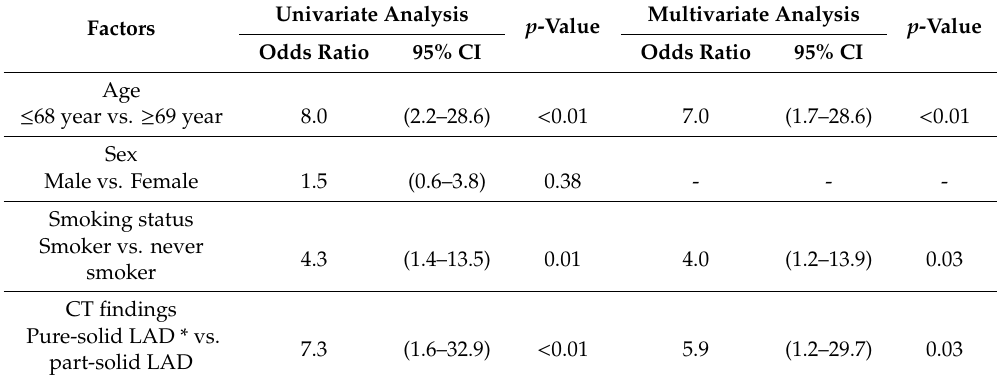
Table 2. Univariate and multivariate analyses for factors related to programmed death ligand-1 (PD-L1) positivity ≥